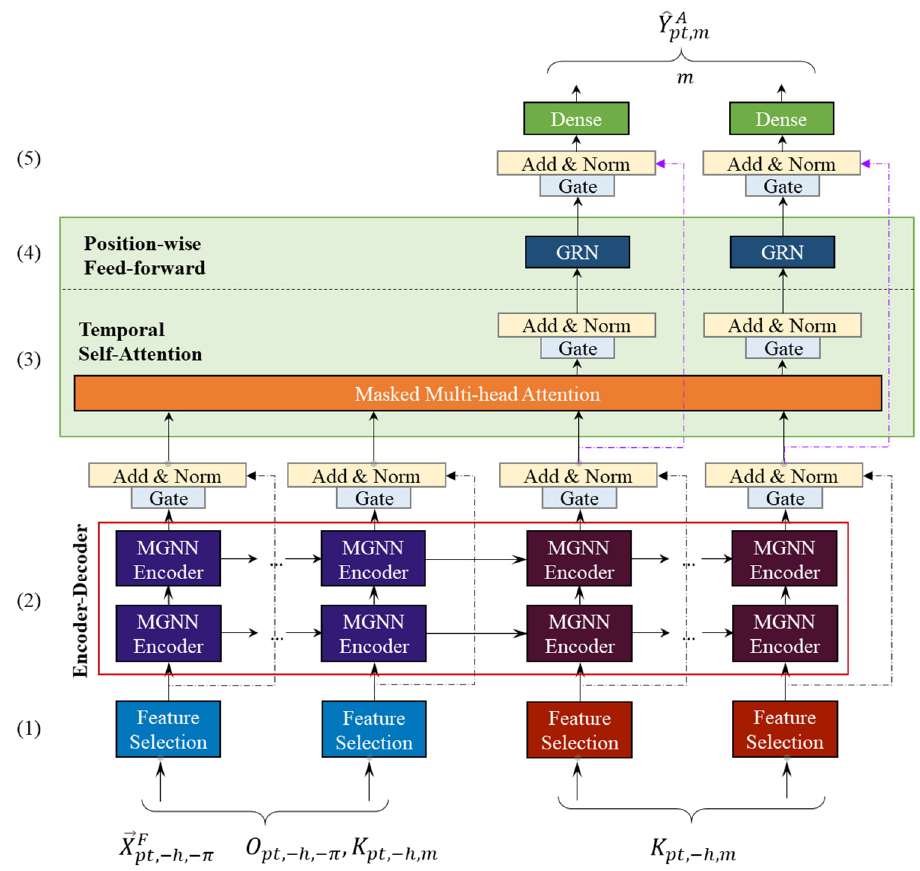
Figure 3. The framework of Graph–Temporal Fused Neural Network (GTFNN).